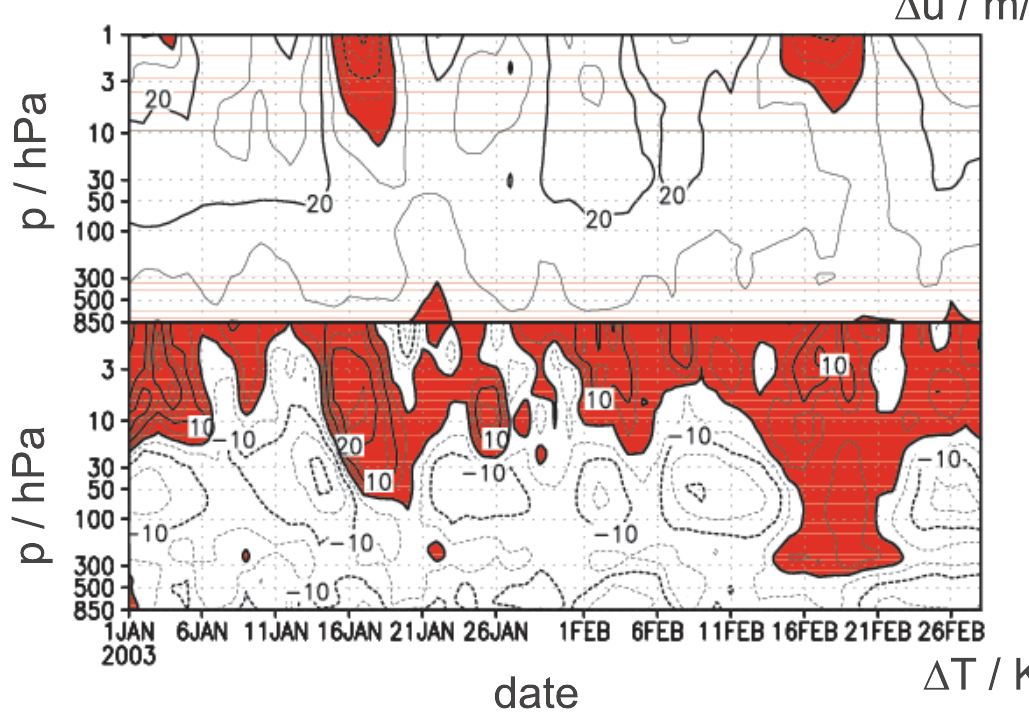
Fig. 1. Time-height section of zonal mean zonal wind in m/s (upper plot) at 60 ◦ N and of temperature gradient in K (lower plot) between 60 ◦ N and the North Pole from 1 January to 28 February 2003 (ECMWF data); westward winds and positive temperature gradients are red. The ordinate is atmospheric pressure in